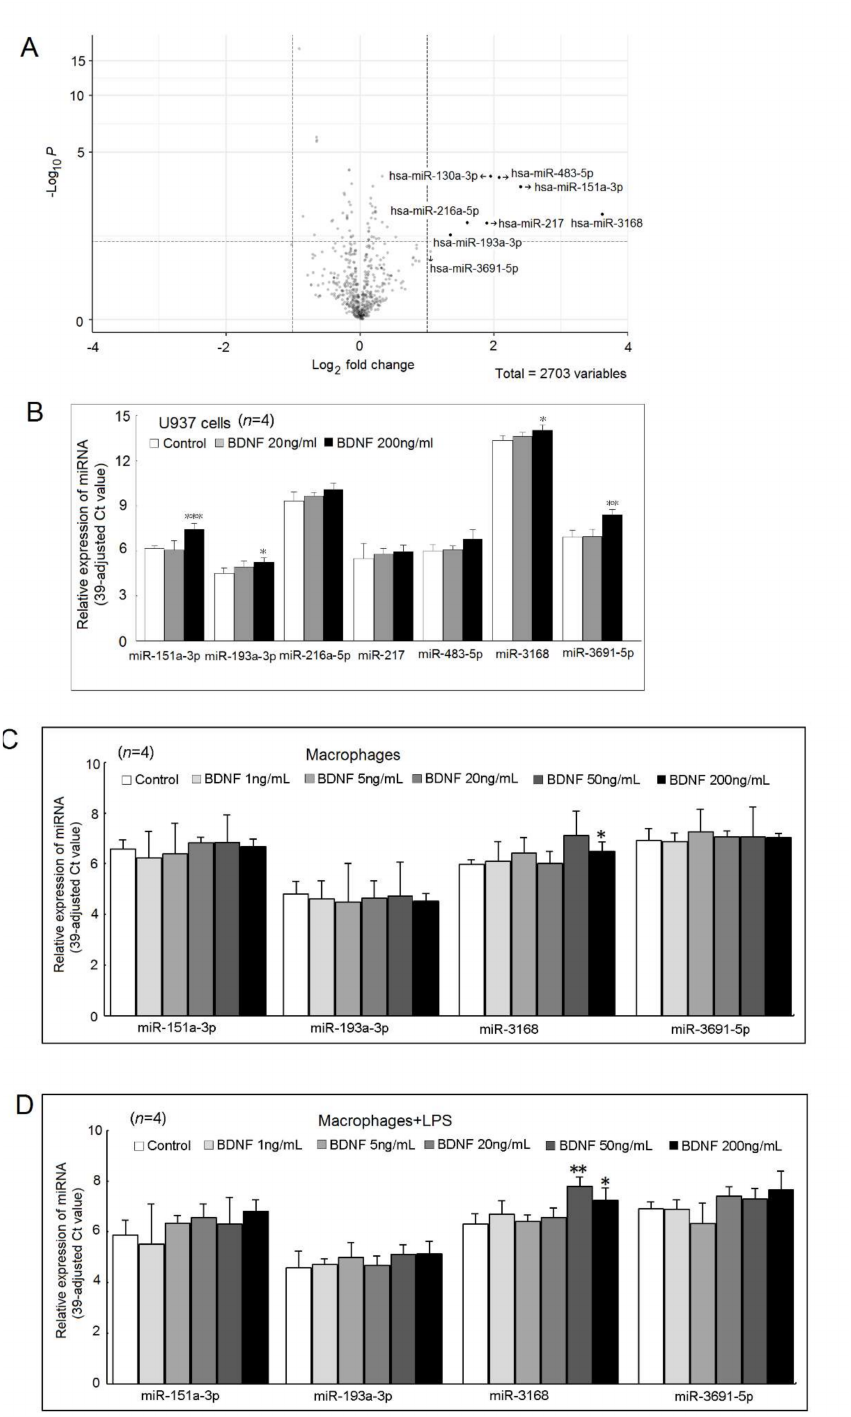
Figure 7. Differential expression of BDNF-regulated miRNA in U937cells cultured with BDNF (200 ng/mL) for 48 h or medium only. ( A ) Expression profiles of miRNAs in U937 cells cultured with BDNF (200 ng/mL) or medium only for 48 h, were evaluated using miRNA-Seq transcriptome analysis. Each scatter point represents the mean read count of miRNA in three repeats of each treatment; ( B ) Validation of potential candidates of BDNF-regulated miRNAs in U937 cells. Because the expression of miR-130a-3p was too low, we did not include it in the validation stage. Among the BDNF-regulated miRNAs, only miR-3168 was increased in ( C ) differentiated macrophages or ( D ) LPS-stimulated macrophages (* p < 0.05; ** p < 0.01; *** p <